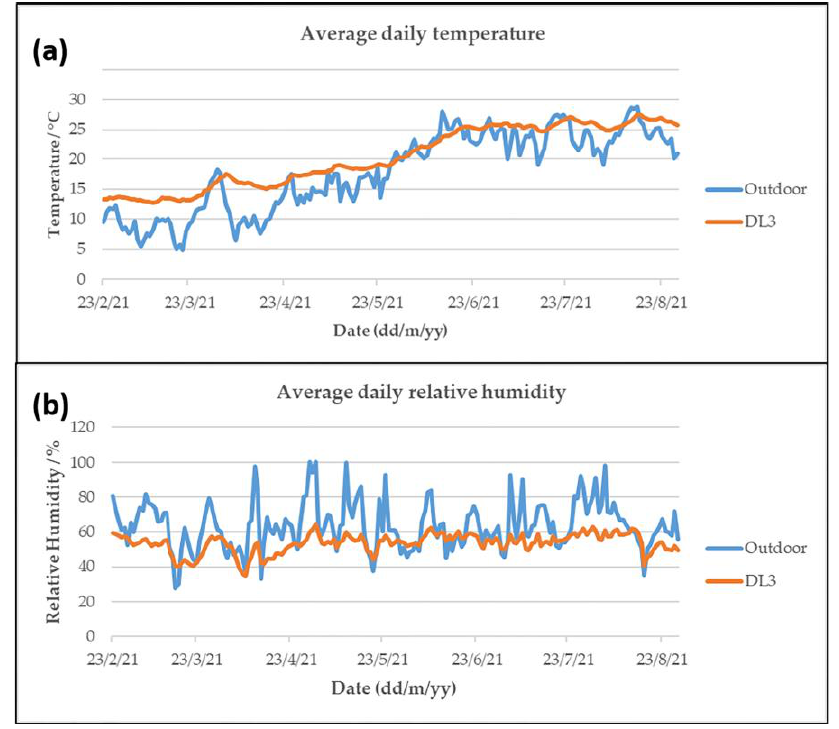
Figure 1. ( a ) The average daily temperature and ( b ) average daily relative humidity values reported for DL3 compared to the outdoor trends. Table 3. Percentage of overrun days of the limits indicated in the UNI 10829:1999 technical